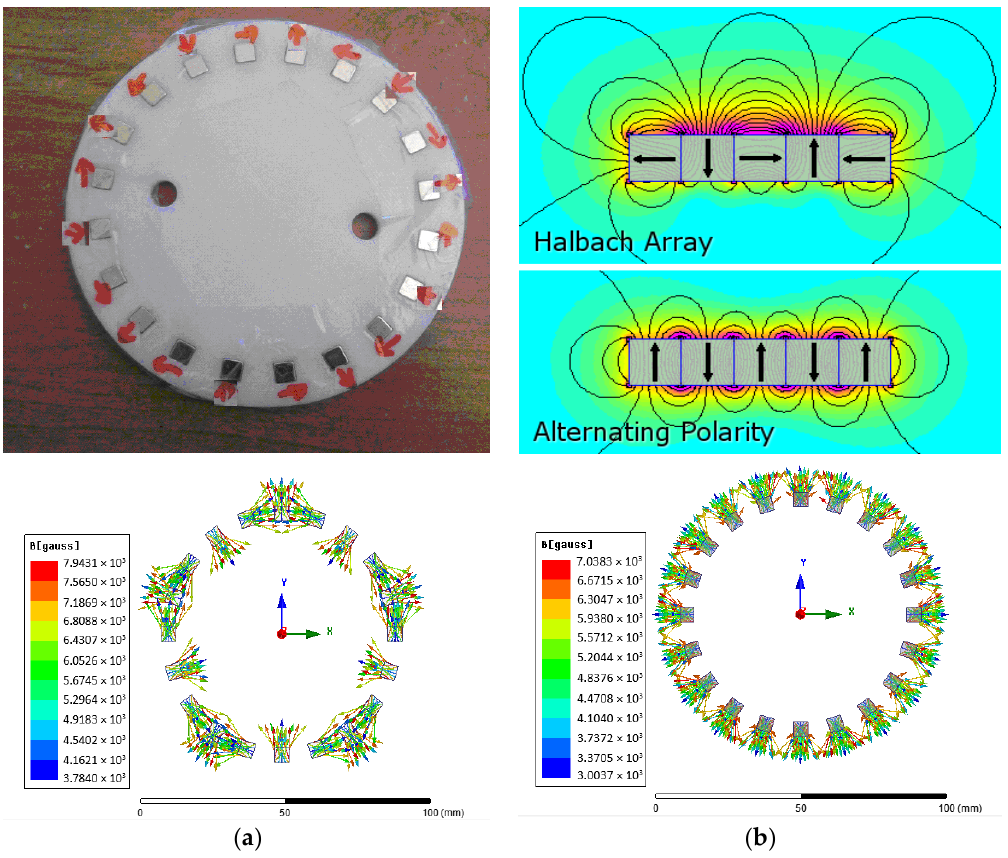
Figure 4. A ring array of 20 neodymium magnets inserted in the disk and the magnetic flux distributions of the topology opening up of the ring array for ( a ) the Halbach and ( b ) alternating transverse polarity magnet arrangements.